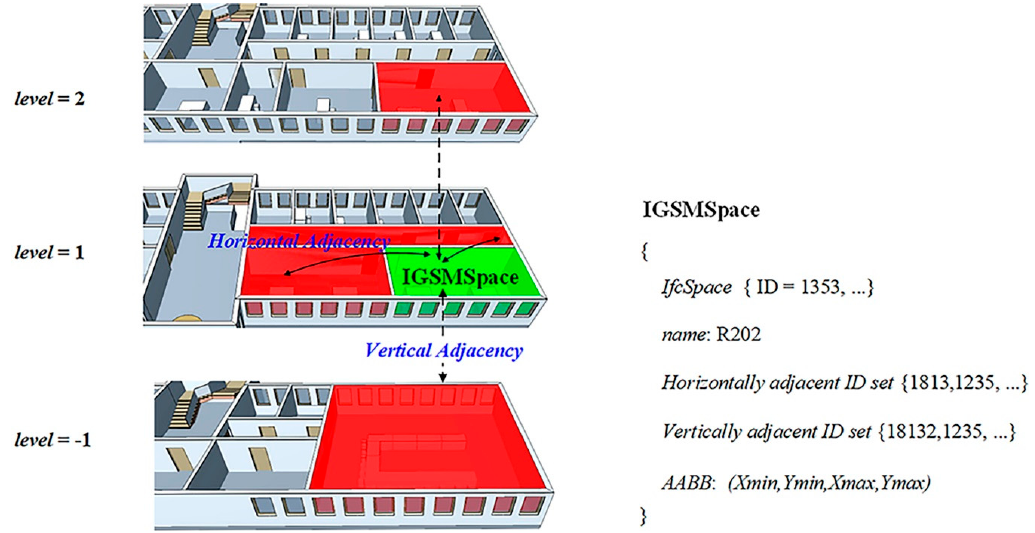
Figure 7. Diagram of IGSMSpace.